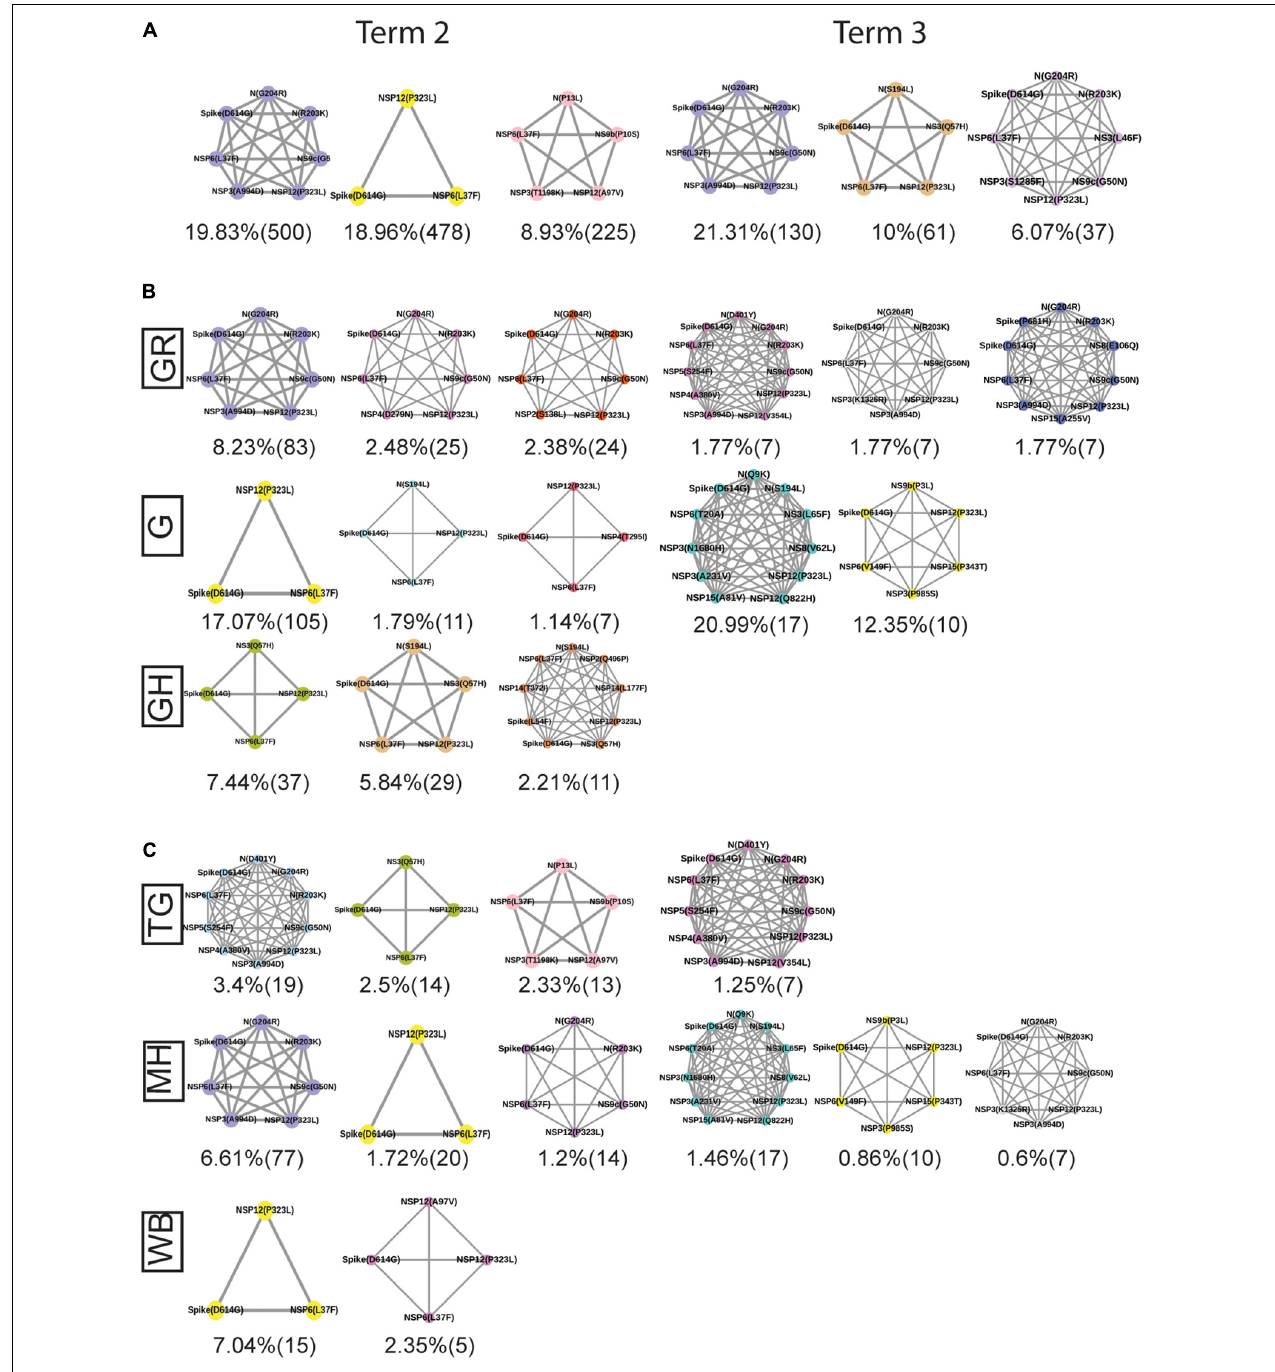
FIGURE 9 | Spatio-temporal variation in the most frequent co-mutations in India. (A) The most frequent three co-mutations in Term2 and Term3 in India. (B) The most frequent three co-mutations in Term2 and Term3 in the major clades of India. (C) The most frequent three co-mutations in Term2 and Term3 in the different states of India. The co-mutation network observed in at least five patients are represented. Different color codes are used for specific co-mutation network motifs. The network motifs were sorted and ranked exclusively.